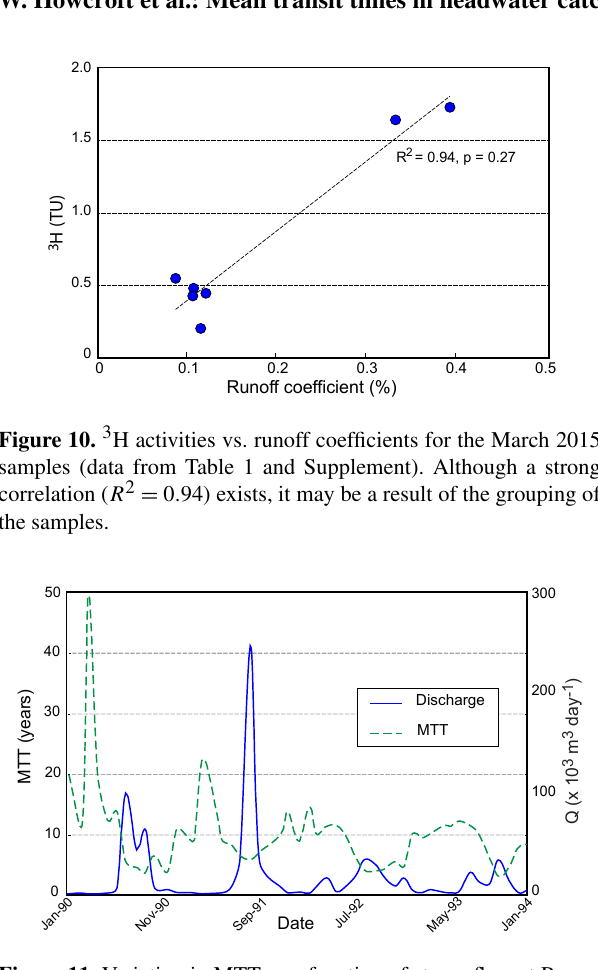
Figure 11. Variation in MTT as a function of streamflow at Porcu- pine Creek for January 1990 to January 1994 calculated using the relationship between EC and 3 H activity (Supplement) and monthly EC data from the Department of Environment, Land, Water and Planning (2017). Streamflow data also from Department of Envi- ronment, Land, Water and Planning (2017).